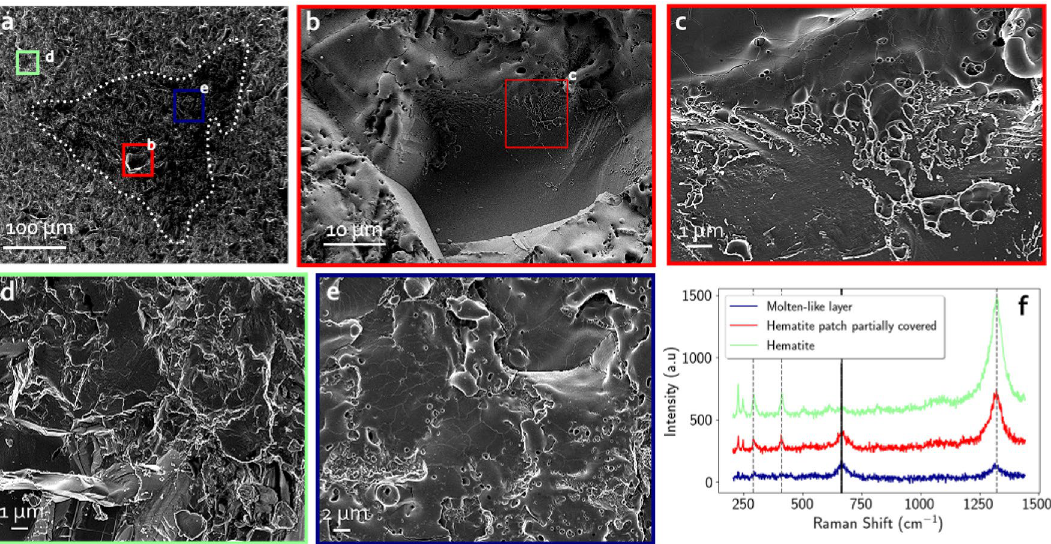
Figure 2. SEM images of the 1 shot deep crater in hematite. ( a ) Overview of the crater where its borders are indicated by a dotted line. Locations of the three zoomed images are represented by color squares. ( b , c ) Two subsequent zooms on a hematite patch partially covered by molten ejecta. ( d ) Zoom on the pristine hematite outside of the laser impacted zone. ( e ) Zoom on the molten-like layer ( f ) Raman spectra acquired in the color- associated area inside the crater. The vertical dashed grey lines highlight the main hematite bands at 291 cm 411 cm − 1 , and 1322 cm − 1 . The vertical solid black line highlights the main magnetite band at 664 cm − 1